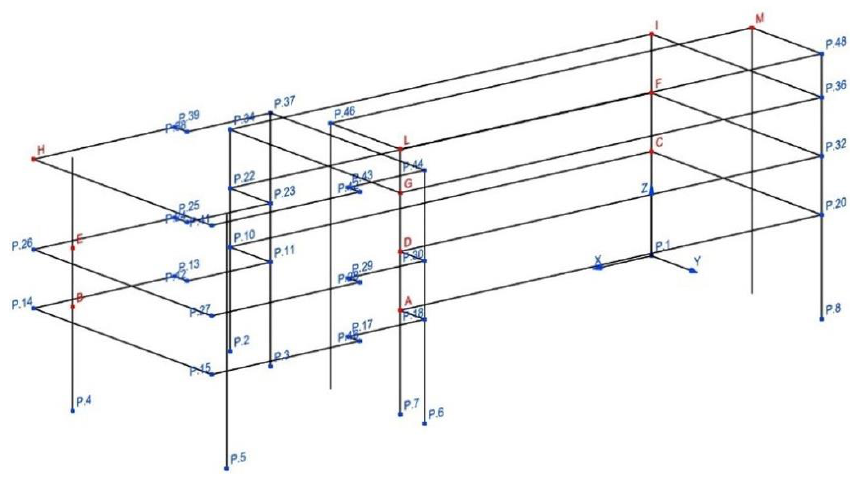
Figure 10. Identified monitoring points—Structure B.